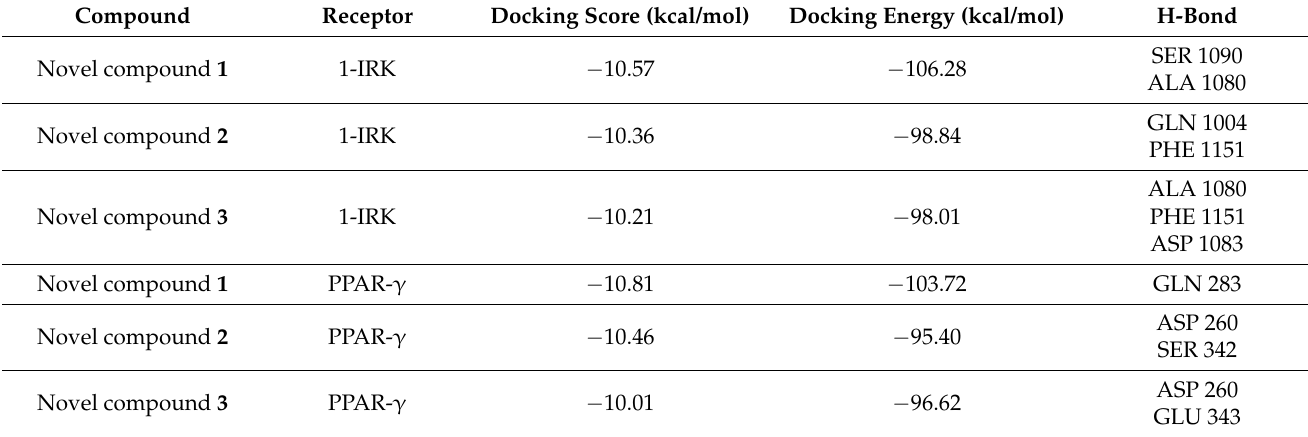
Table 1. Glide score and glide energy of 3 novel compounds with 1-IRK and PPAR- γ